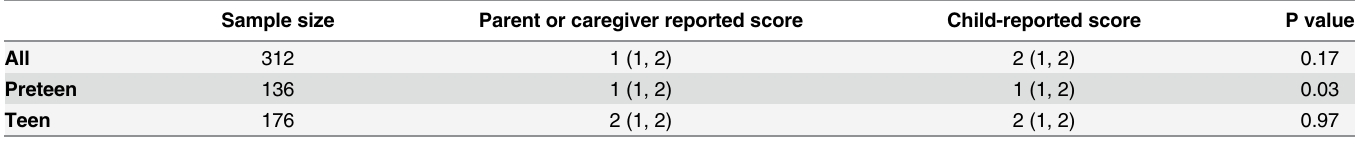
Table 3. Parent- versus self-reported Teen STOP-Bang scores. Sample